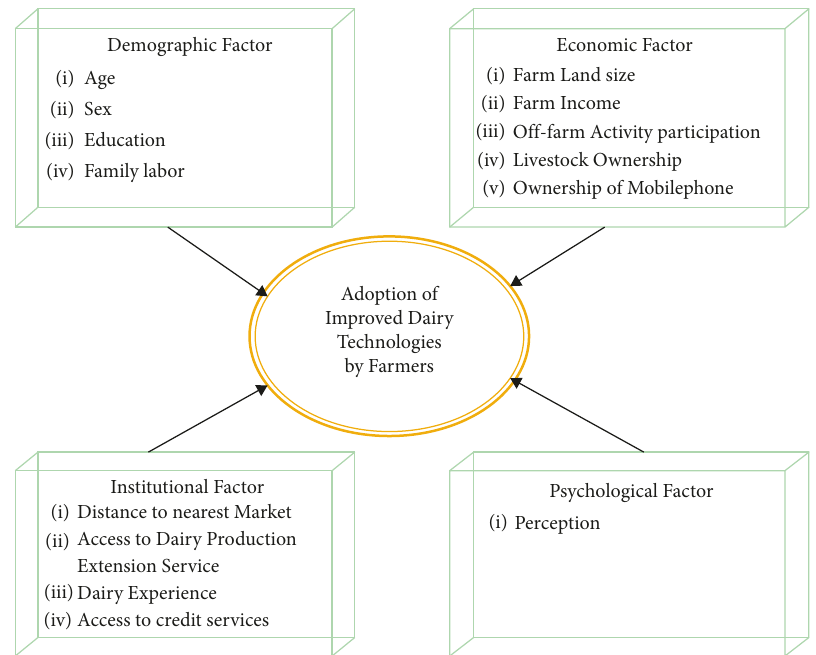
Figure 1: Conceptual framework of the study (source: own conceptual framework of the study,